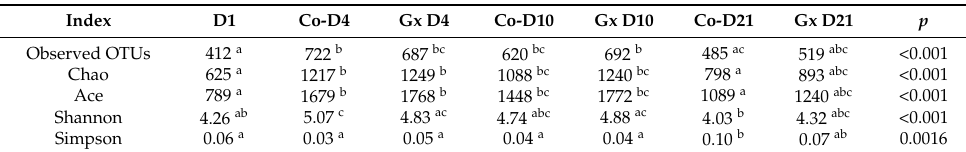
Table 2. Analysis of alpha diversity indices across the supplemented (Gx) or non-supplemented (Co) groups investigated in this study. Different superscripts in the same row indicate that groups are significantly different by the Wilcoxon pairwise test.